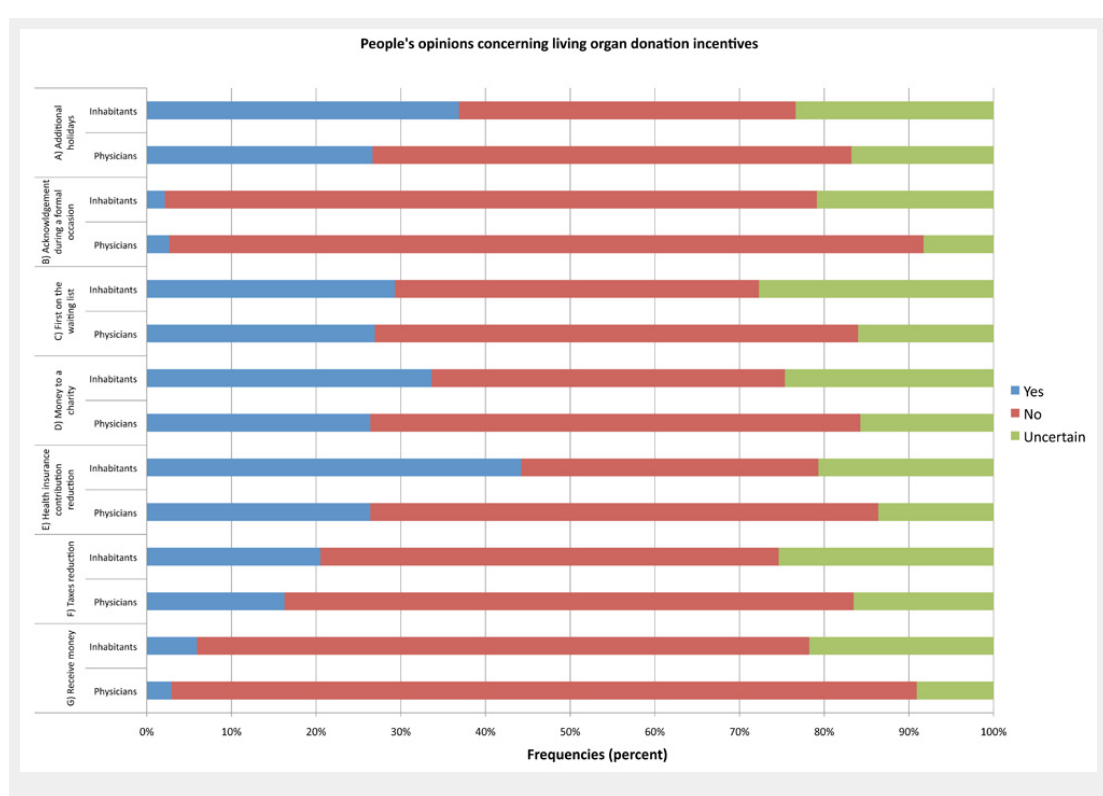
Figure 2 Distribution of the physicians’ and inhabitants’ answers to the different living organ donation incentive